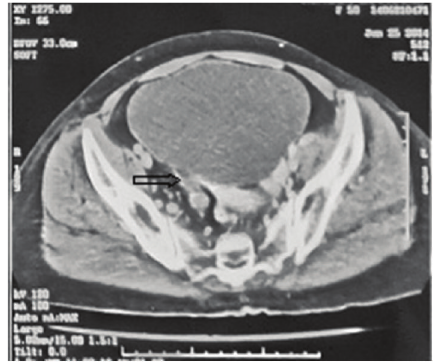
Figure 2: Presence of dilated ureter up to terminal part.